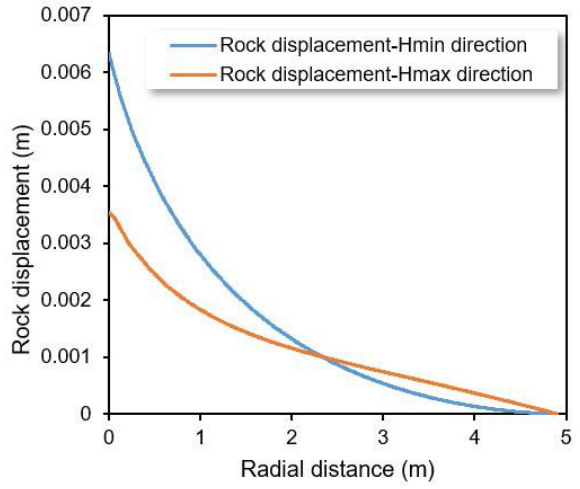
Figure 11. Variations in the rock displacement from CSMP++ along the radial distance from the wellbore for the 2D poroelasticity steady-state simulation.